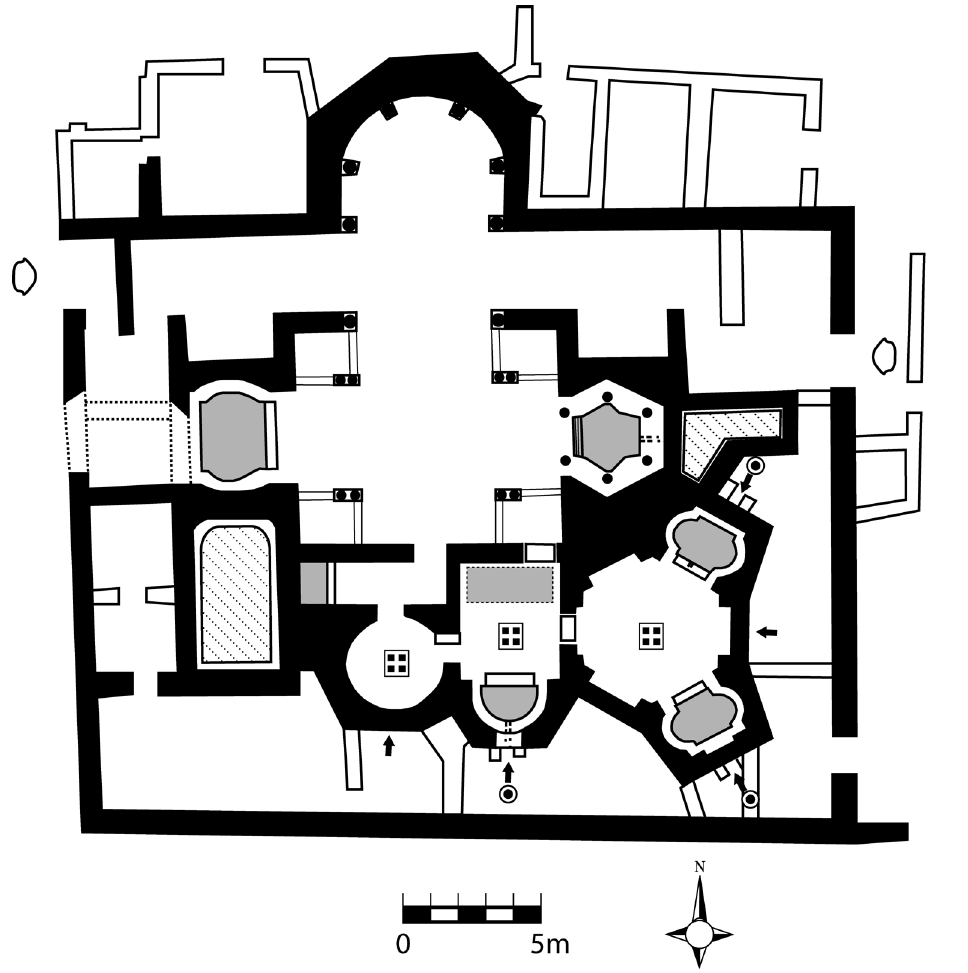
Figure 5: The baths in Sidi Ghrib (after Ennabli 1986: 3,